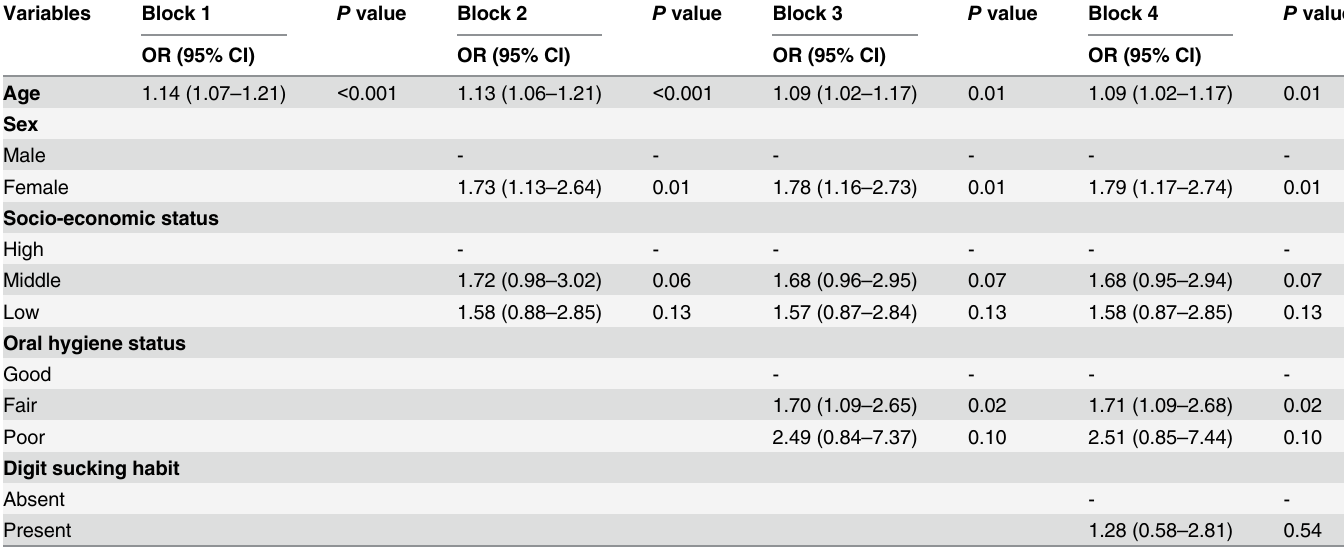
Table 4. Logistic regression determining predictors of caries presence in a sample of 983 children.